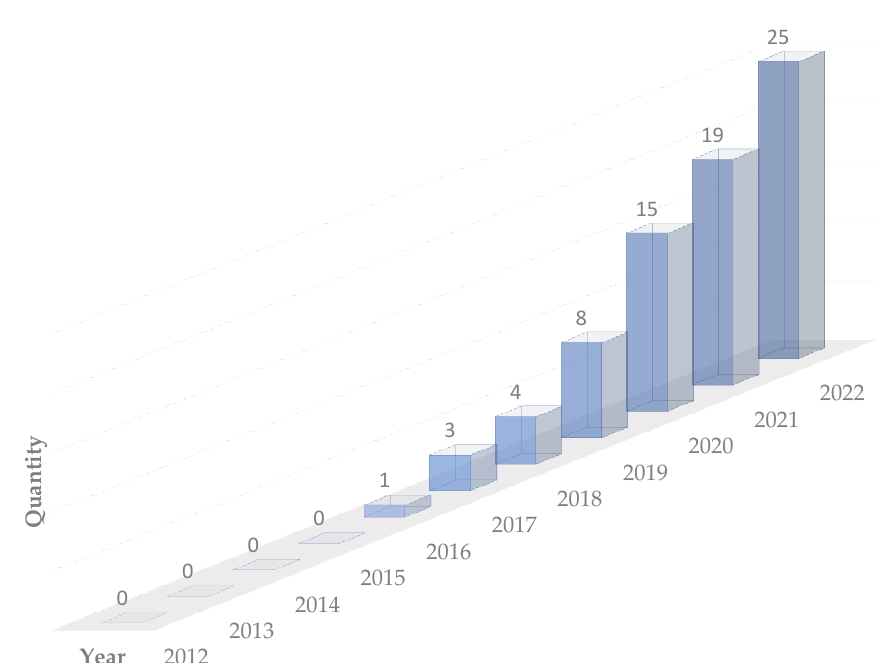
Figure 3. The number of publications published each year between 2012 and 2022.